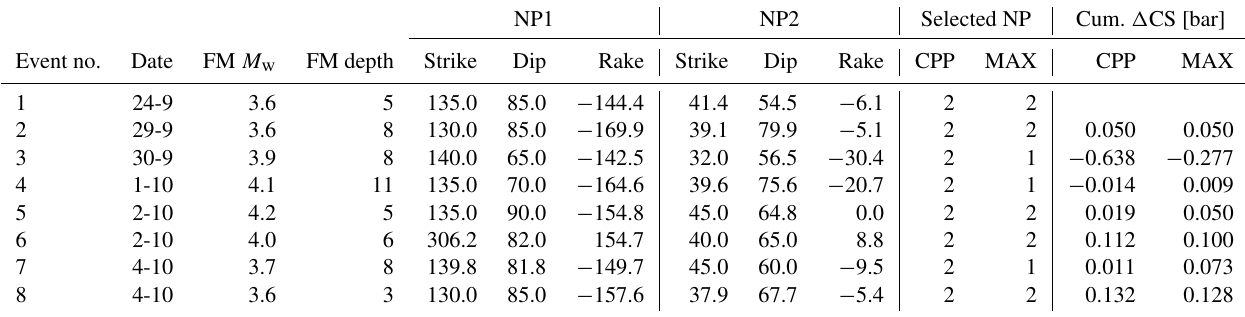
Table 5. Nodal plane pairs for each FM solution. Selected NPs based on a CPP criterion and maximum cumulative (cid:49) CS (MAX) before occurrence are shown, as are the resolved cumulative (cid:49) CS values on each NP just before slip. NP1 NP2 Selected NP Cum. (cid:49) CS [bar] Event